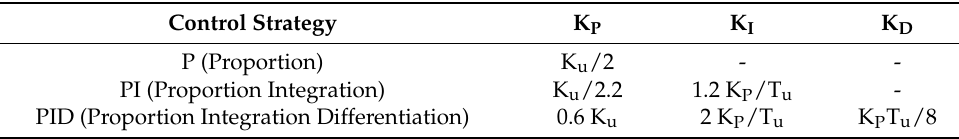
Table 1. Ziegler–Nichols method for control parameter